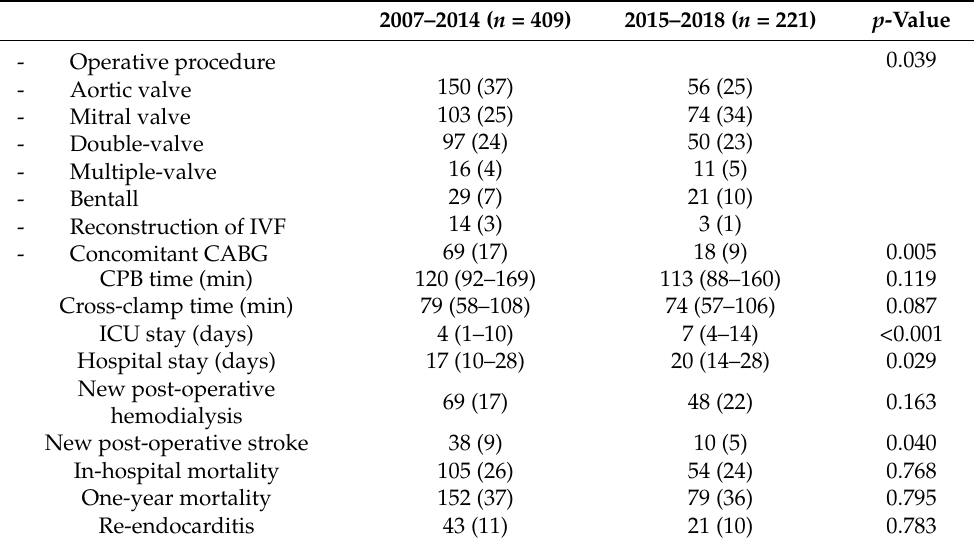
Table 2. Post-operative outcomes for patients operated in the first era (2007–2014) and in the second era